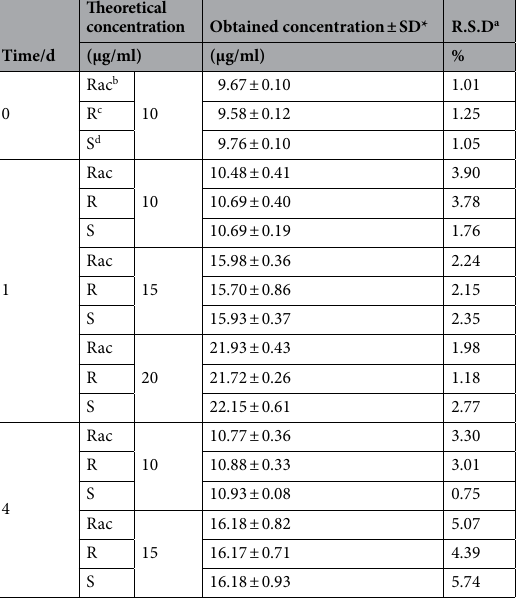
Table 1. Precision and accuracy of the method for the analysis of HCQ and its enantiomers. *n = 3; a relative standard deviation; b racemic HCQ; c R-enantiomer; d